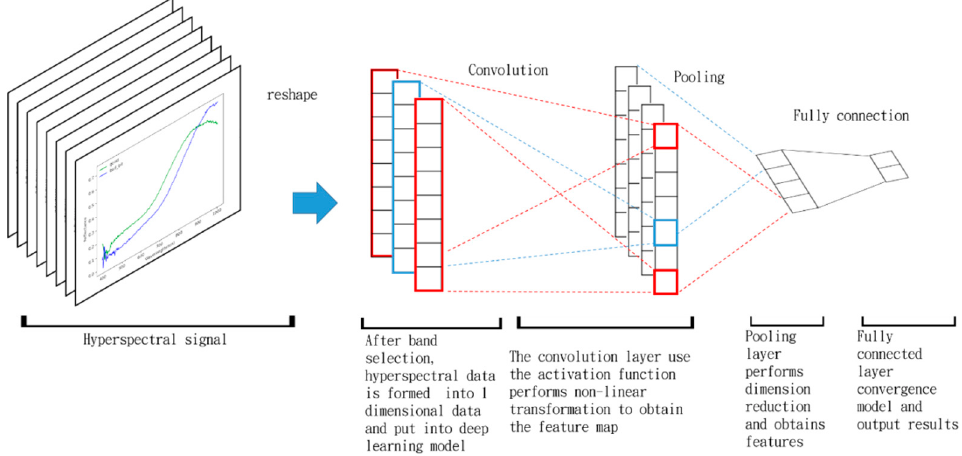
Figure 7. The 1D-CNN model.